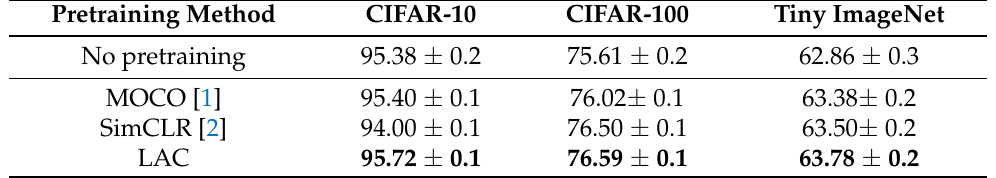
Table 2. Top-1 accuracy (%) for the classification task of CIFAR-10/100 test datasets and Tiny ImageNet validation dataset after fine-tuning. “No pretraining” means supervised training from scratch. The best results are in